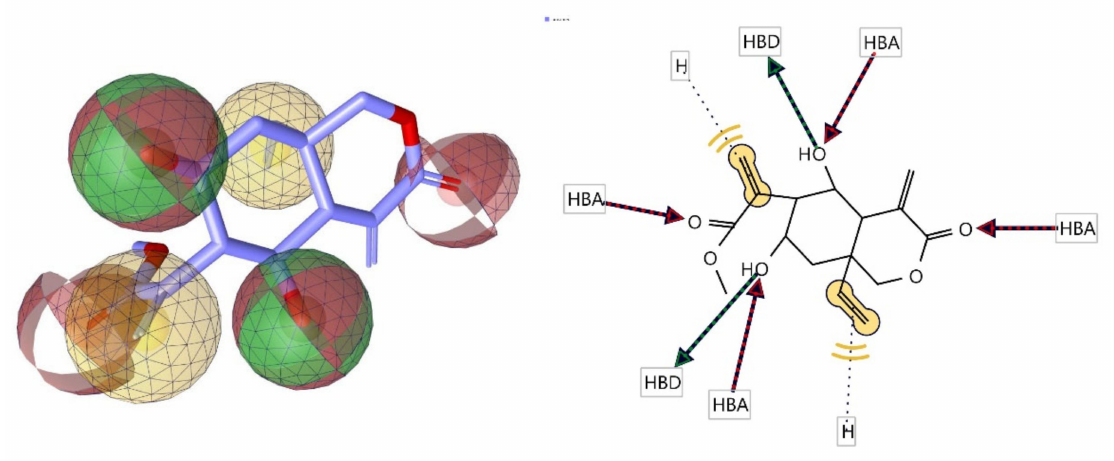
Figure 10. 3D and 2D representations of common pharmacophoric features of lasiopulide used in pharmacophore evaluation. Red, HBAs; green, HBDs; Yellow, H; as described